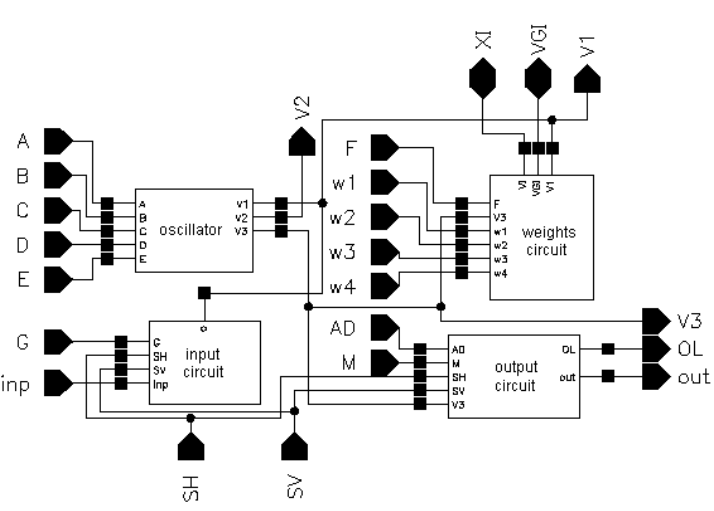
Figure 3. Block diagram of the SON cell.